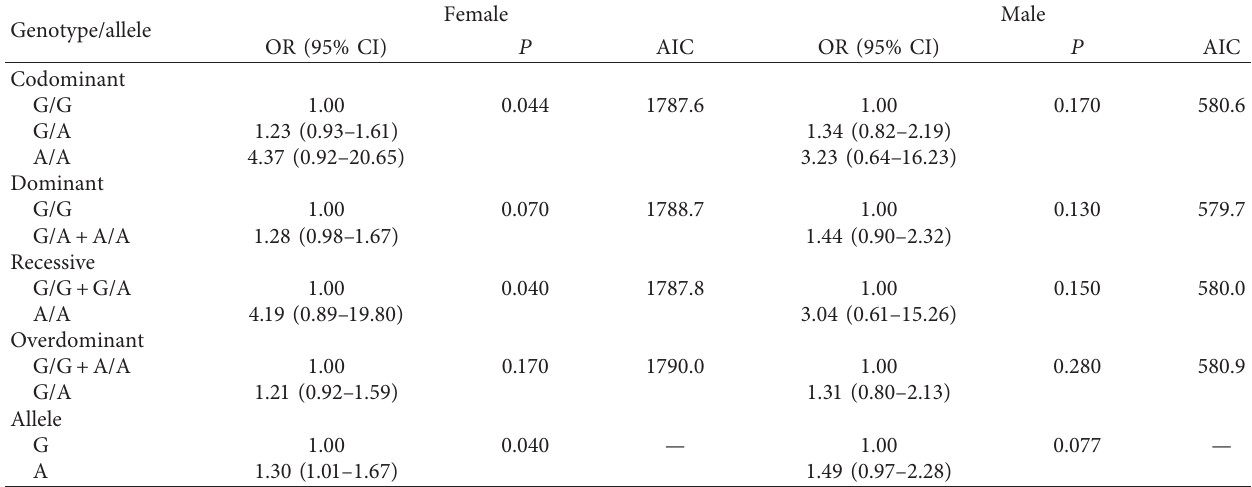
Table 8: Association between rs965513 polymorphism and PTC by